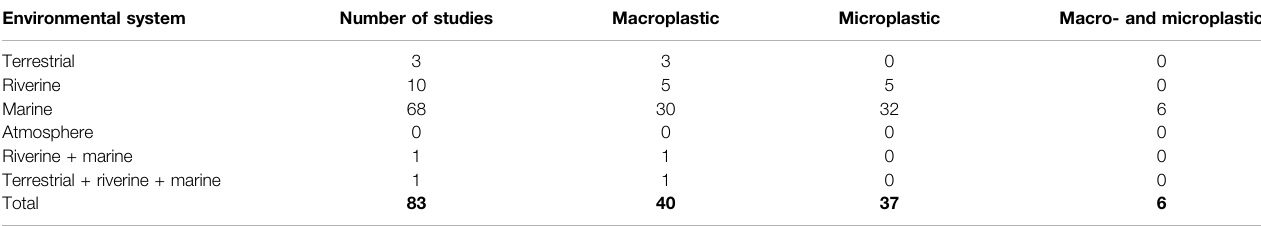
TABLE 1 | Overview of studies included in the meta-analysis sorted by environmental system and size class of plastic considered. Note, we only considered the categories microplastic ( < 5 mm) and macroplastic ( > 5 mm). Numbers are in bold to demarcate that they are totals of the numbers above. Environmental system